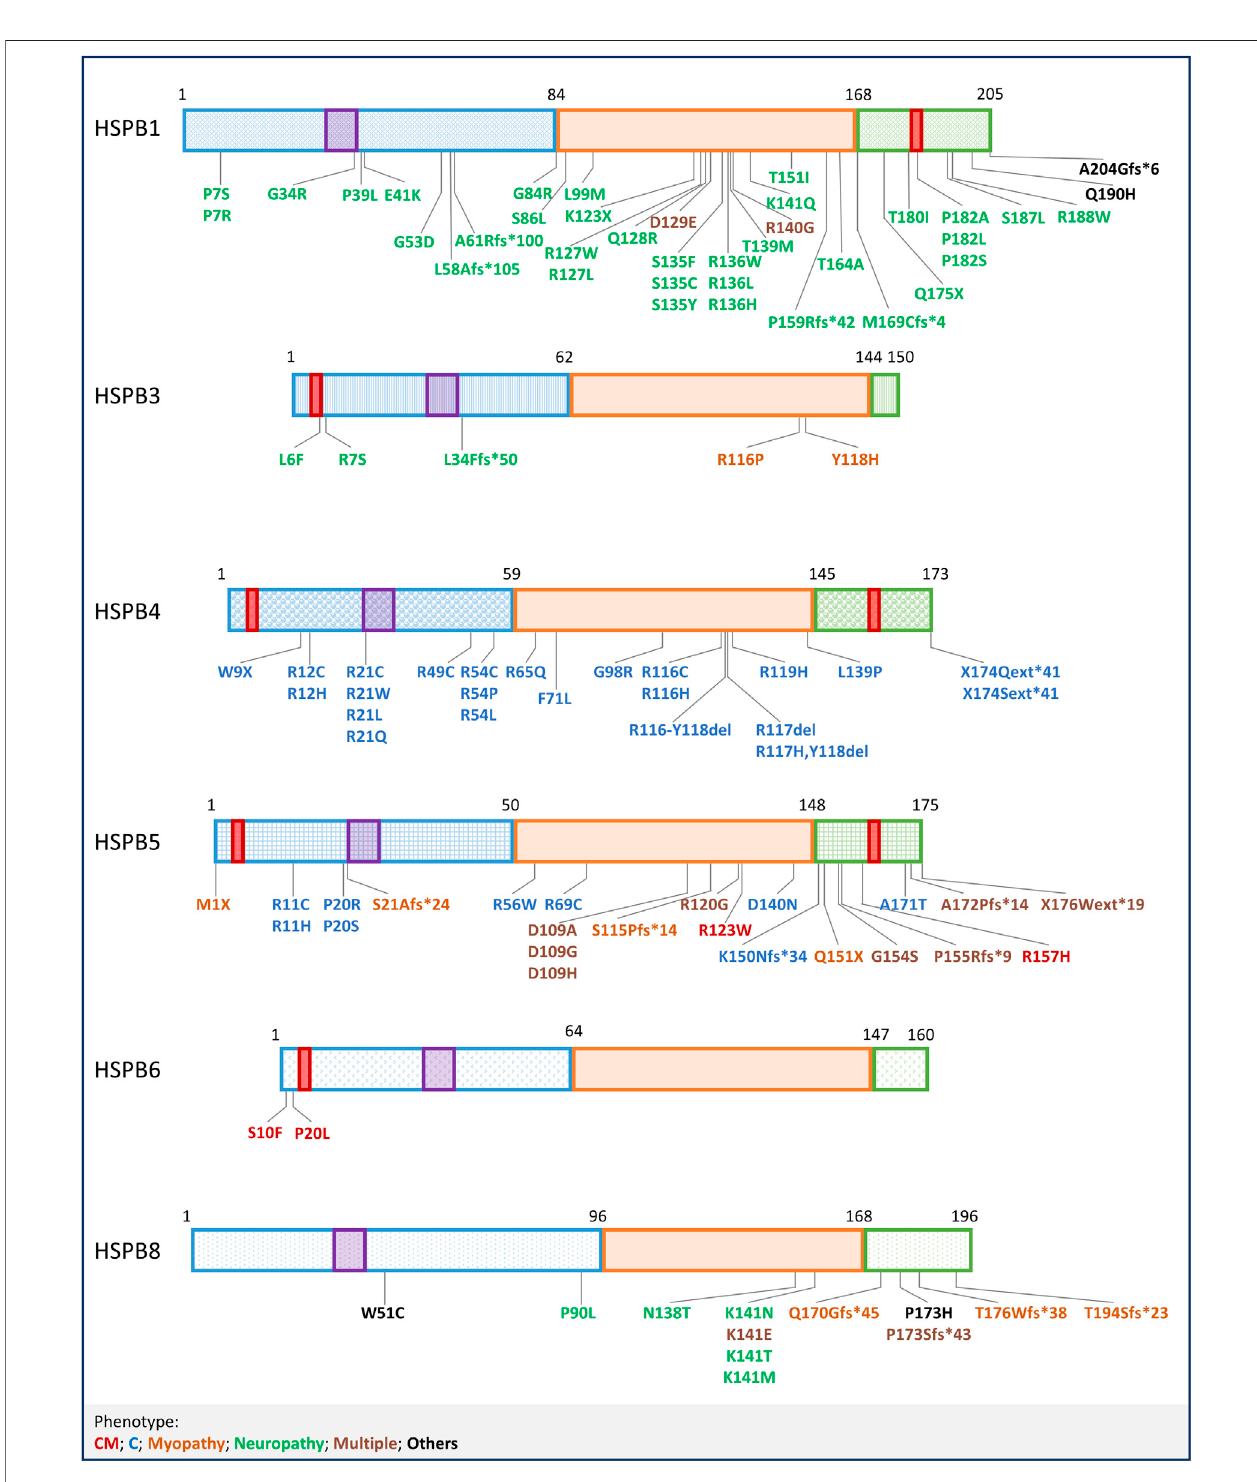
FIGURE 3 | Mutations in HSPBs. Graphical representation of HSPBs structure and mutations, based on Figure 1 . Mutations are labelled with colors corresponding to the phenotypes reported at the bottom. CM = Cardiomyopathy, C=Cataract; Multiple (phenotypes) refers to mutations that have been linked to more than one phenotype, in combination or not; Others refer to mutations not included in the list.